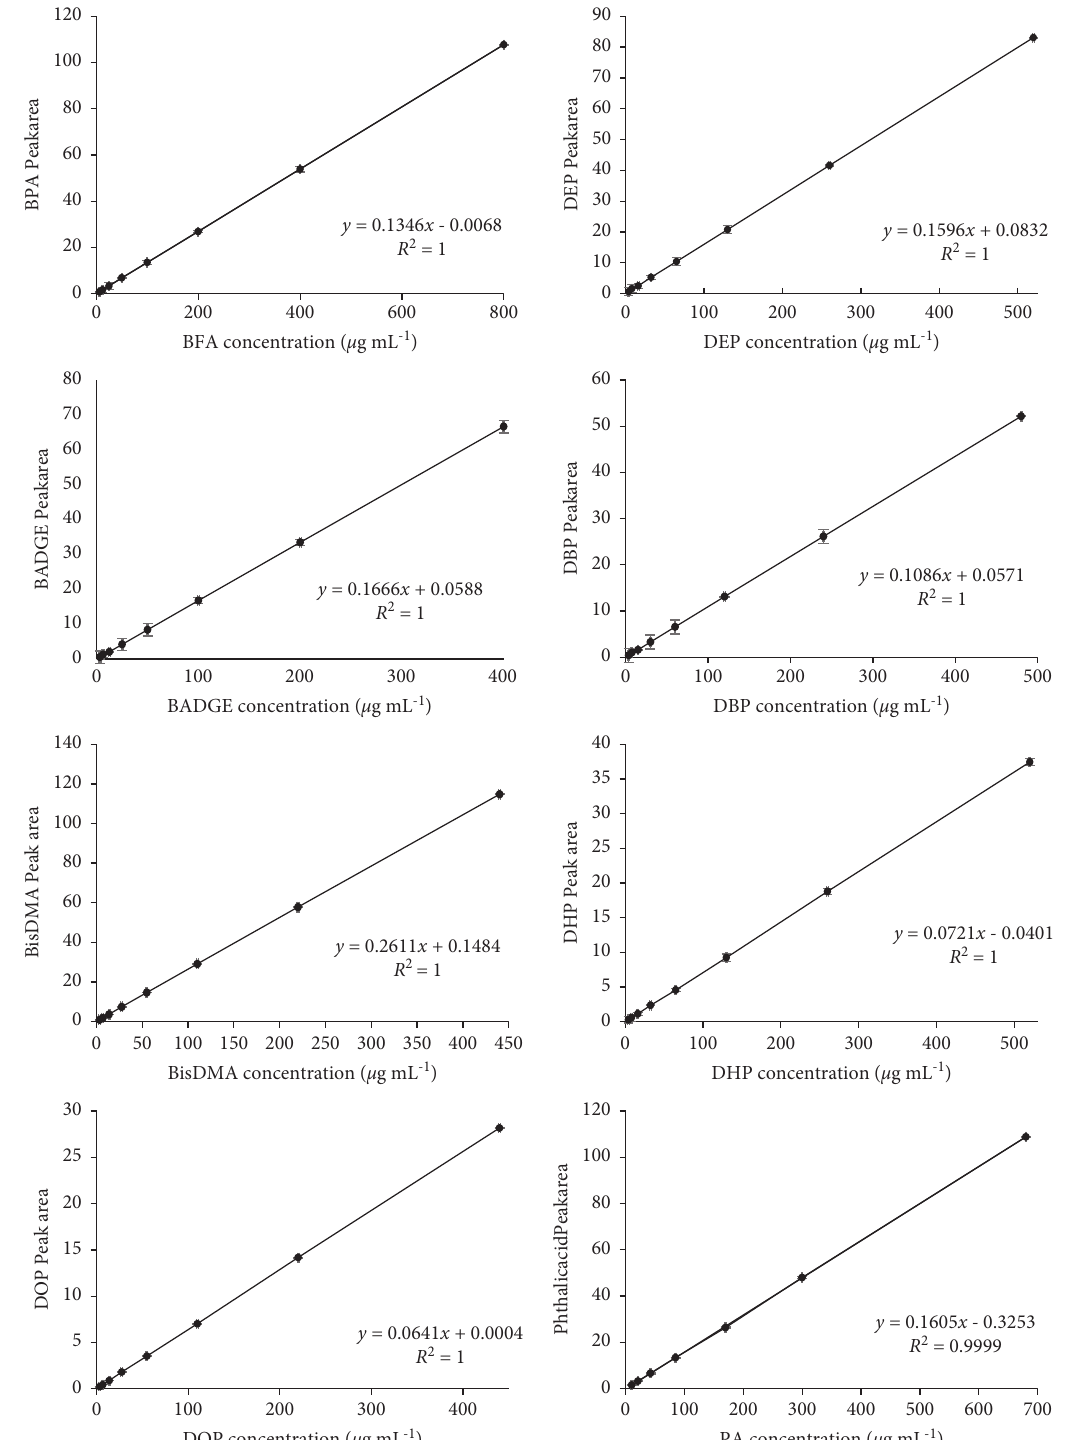
Figure 2: Calibration curves for BFA, DEP, BADGE, DBP, BisDMA, DHP, DOP, and PA. Chromatographic conditions: acetonitrile as mobile phase A and water as mobile phase B, total flow rate of 1.0 mL min − 1 , column temperature of 25 ° C, and injection volume of 5 µ